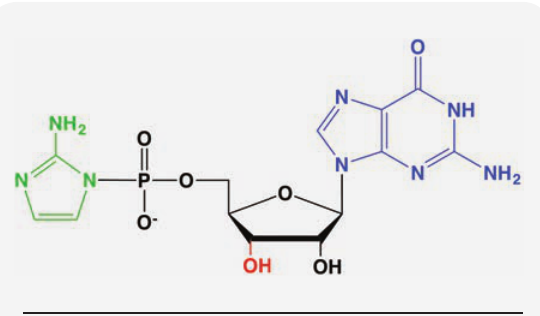
Figure 9. A new leaving group for activated nucleotides: 2-aminoimi- dazole (2AO). Nucleotides activated with 2-aminoimidazole lead to faster and more effi cient primer extension than nucleotides activated with